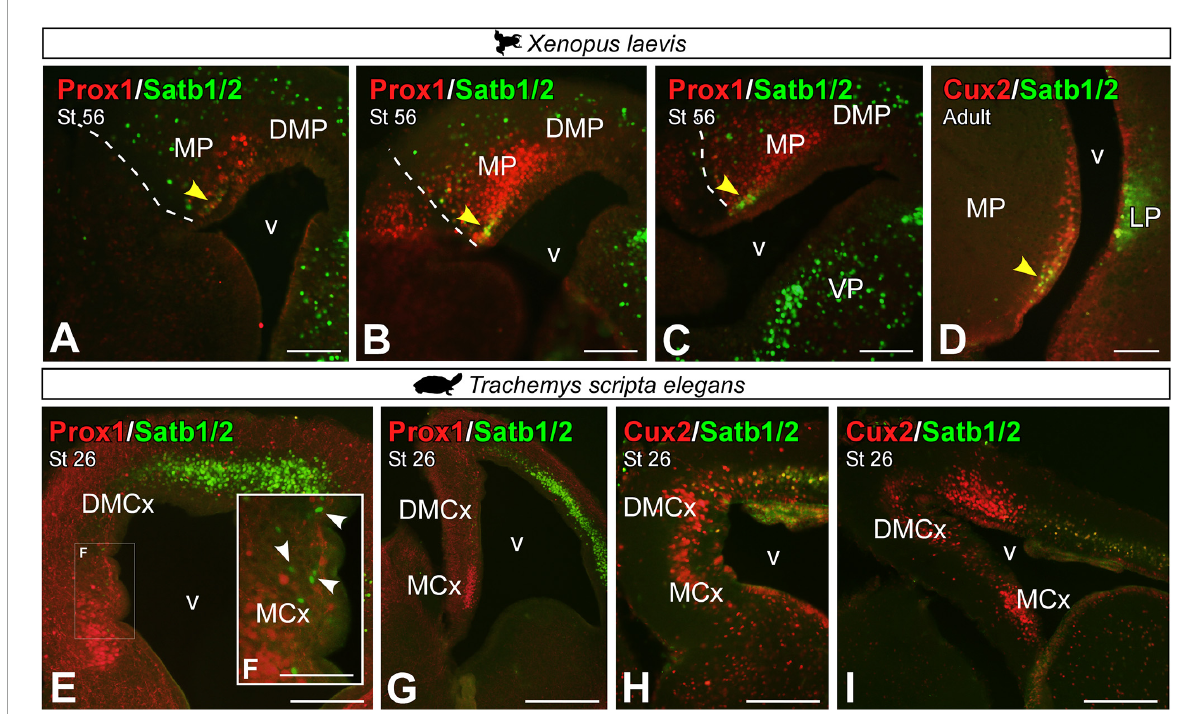
FIGURE12 Photomicrographs of transverse sections through the developing and adult telencephalon of Xenopus laevis (A–D) and Trachemys scripta elegans (E–I) showing the combined expression of Satb1/2 with Prox1 (A–C,E–G) and Cux2 (D,H,I) . In each panel, the developmental stage and the color code for the used markers are indicated. Yellow arrowheads (A–D) indicate double-labeled cells. The white box in Figure (E) corresponds to the magnified photo in panel (F) . The white arrowheads point to Satb1/2 positive cells, no double-labeled. Scale bar in panels (A–E,G–I) = 200 µ m and (F) = 100 µ m. See the abbreviation